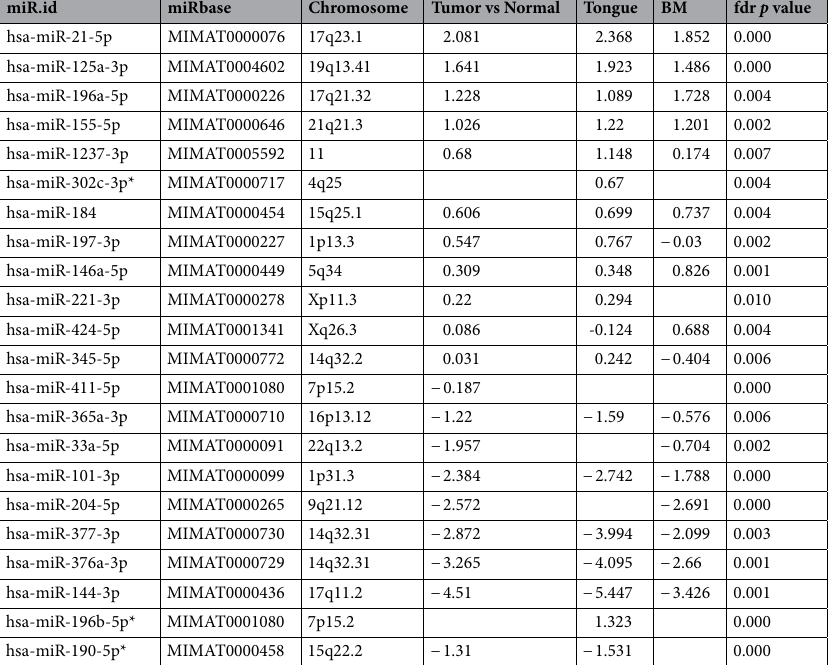
Table 1. Differentially expressed miRNAs in oral carcinoma derived by p value < 0.01 filtering. Log 2 fold change values shown. *miRNAs not part of the 19 signature, expressed in Tongue SCC